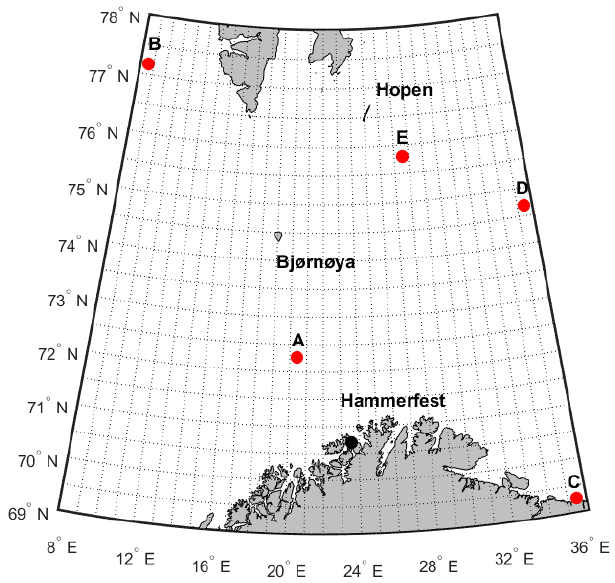
Figure 2. Study scope and five locations selected in the Norwegian Arctic sea areas.